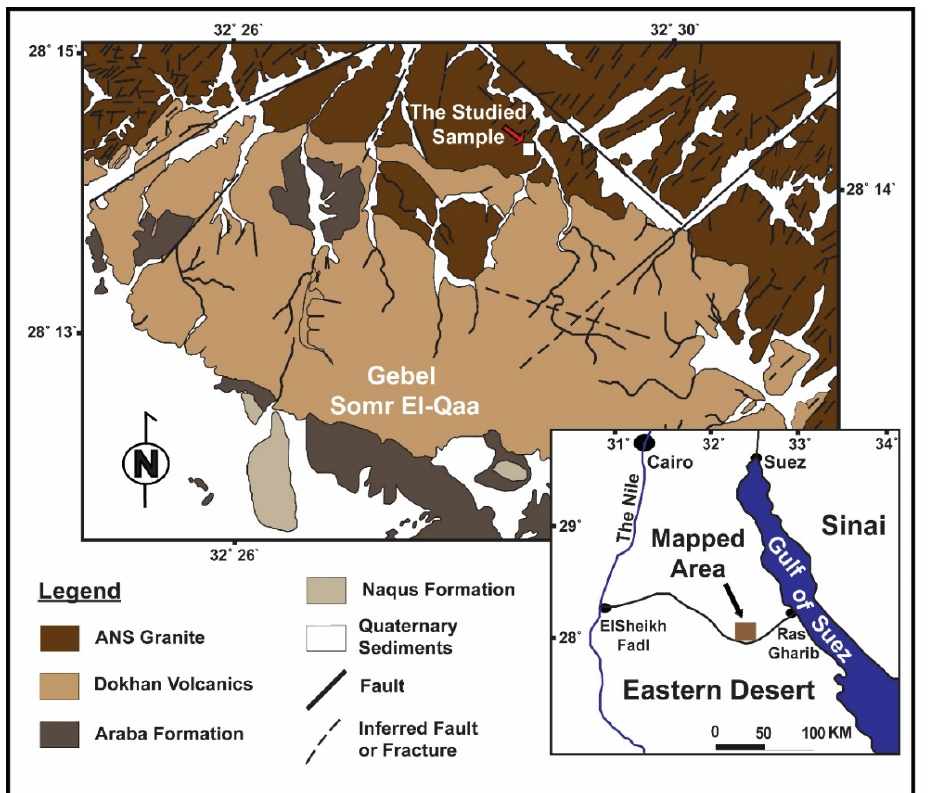
Figure 2. Simplified Geologic Map for Gebel Somr El-Qaa area, NED, Egypt (modified after [70]) representing the studied sample location and the main lithology of the region; the ANS granite (750–530 Ma), Dokhan volcanics (630–570 Ma), Araba and Naqus Formations (Lower Palaeozoic age).